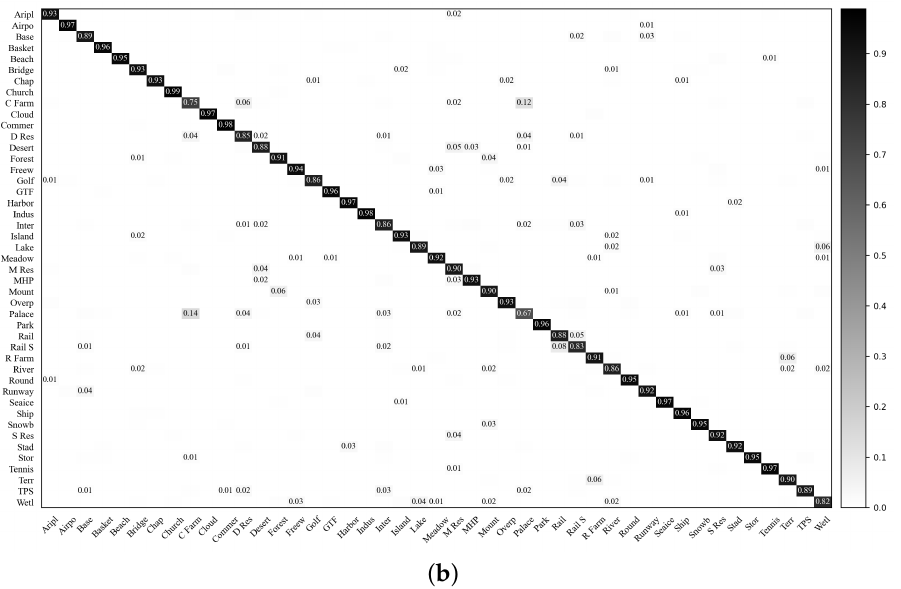
Figure 11. Confusion matrices of the VGG-VD16-based baseline DCNN and RIR-net for the NWPU dataset (training ratio = 20%). ( a ) VGG-VD16-based baseline DCNN; ( b ) VGG-VD16-based RIR-net.